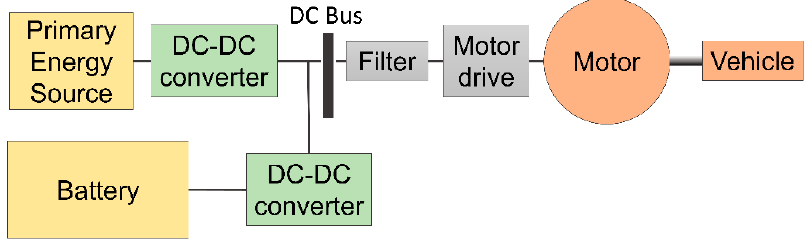
Figure 1. Block diagram of a hybrid electric vehicle power distribution system.